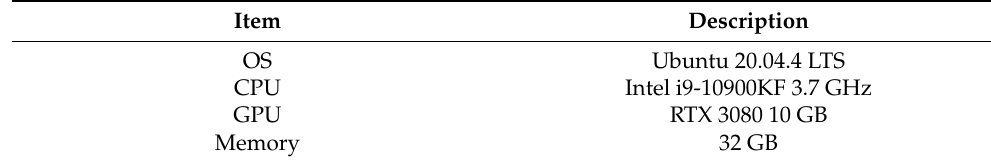
Table 1. Platform configuration for model training and